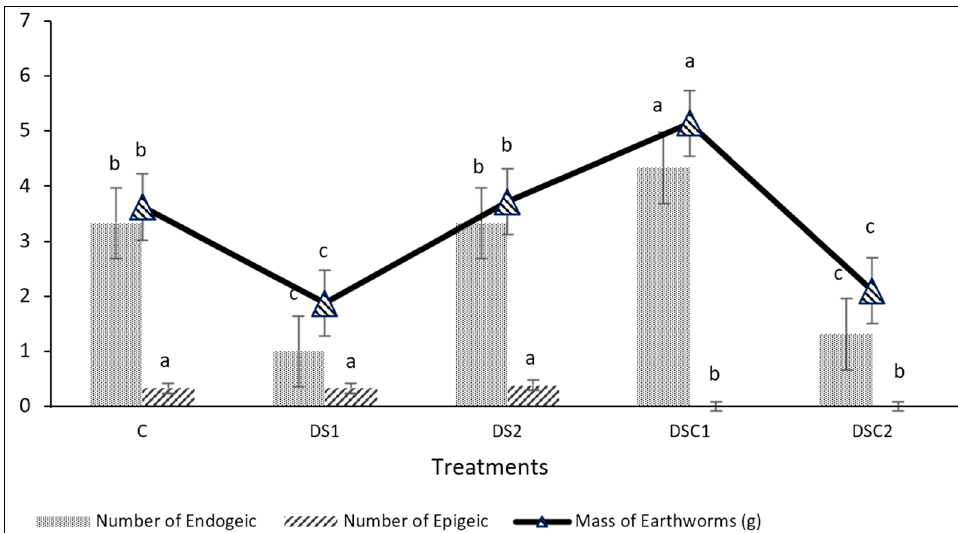
Figure 3. Number and mass of earthworms (epigeic and endogeic) after the application of raw and composted de-inking paper sludge for two years. C: soil control without amendment; DS1: soil amended with raw de-inking sludge at 30 t ha − 1 ; DS2: soil amended with raw de-inking sludge at 60 t ha − 1 ; DSC1: soil amended with composted de-inking sludge at 20 t ha − 1 ; DSC2: soil amended with composted de-inking sludge at 40 t ha − 1 . For each parameter, sample mean values with the same letters are not statistically different at p ≤ 0.05.